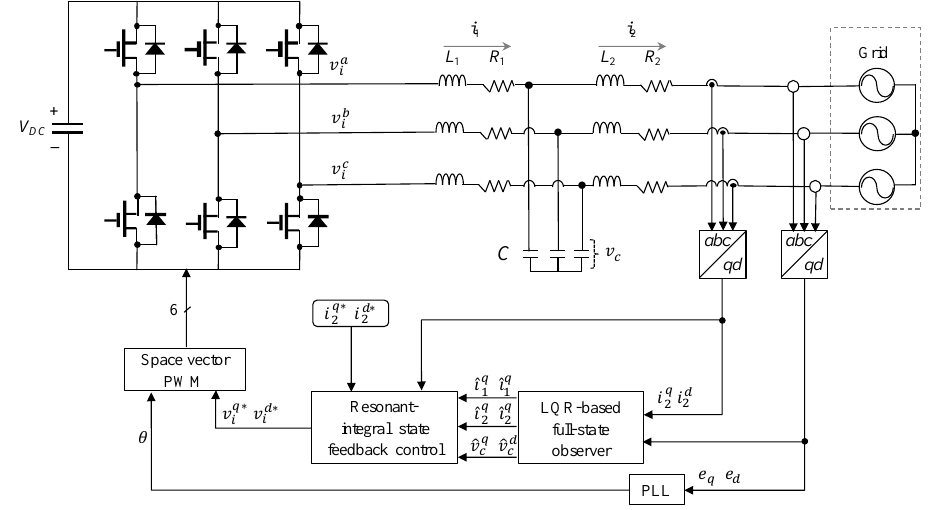
Figure 2. Block diagram of the proposed integral-resonant state feedback current control scheme with observer.